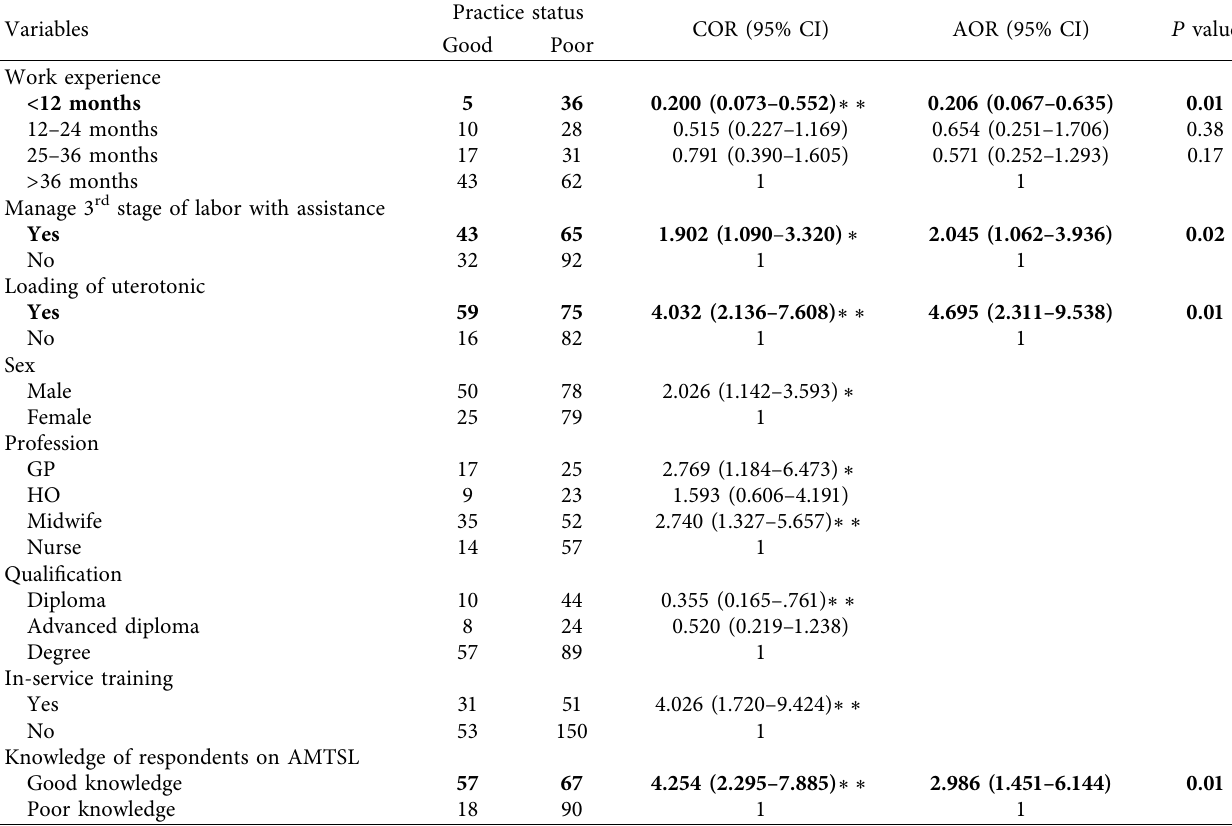
Table 6: Bivariate and multivariable analysis, on factors associated with obstetrics care providers’ practice on active management of third stage of labor, 2020.